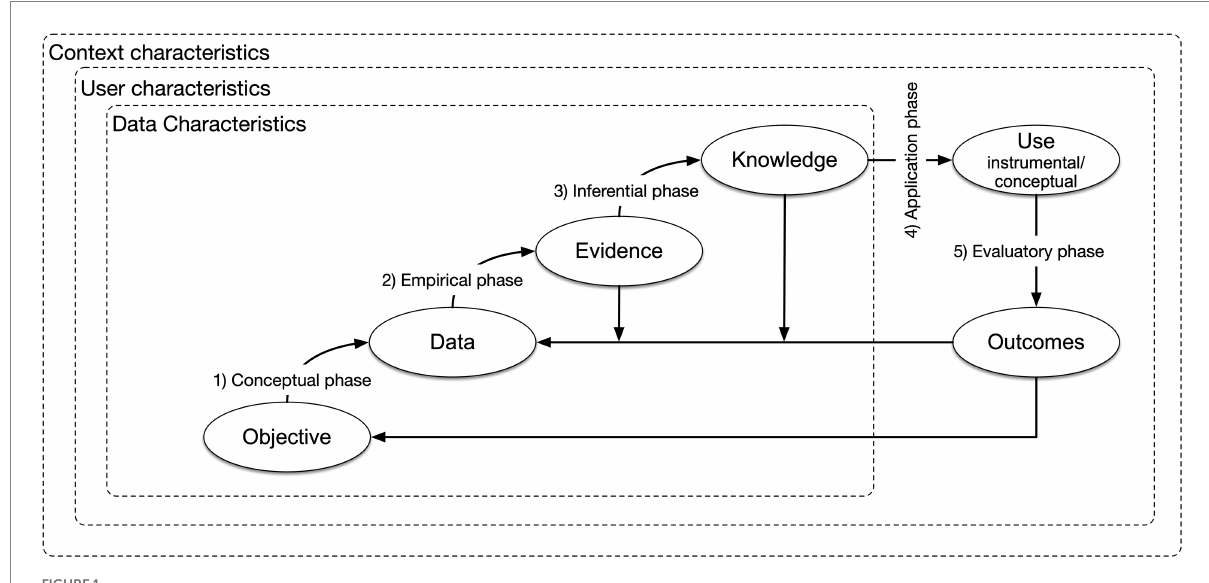
FIGURE 1 Conceptual framework of research informed-educational practice (adapted, a.o. Mark and Henry, 2004; Mandinach et al., 2008; Marsh, 2012; Schildkamp and Poortman, 2015; Schratz et al., 2018; Groß Ophoff and Cramer,